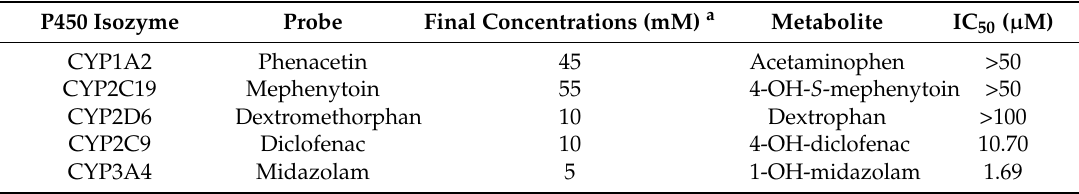
Table 3. Some experiment parameters and cytochrome P450 inhibition.